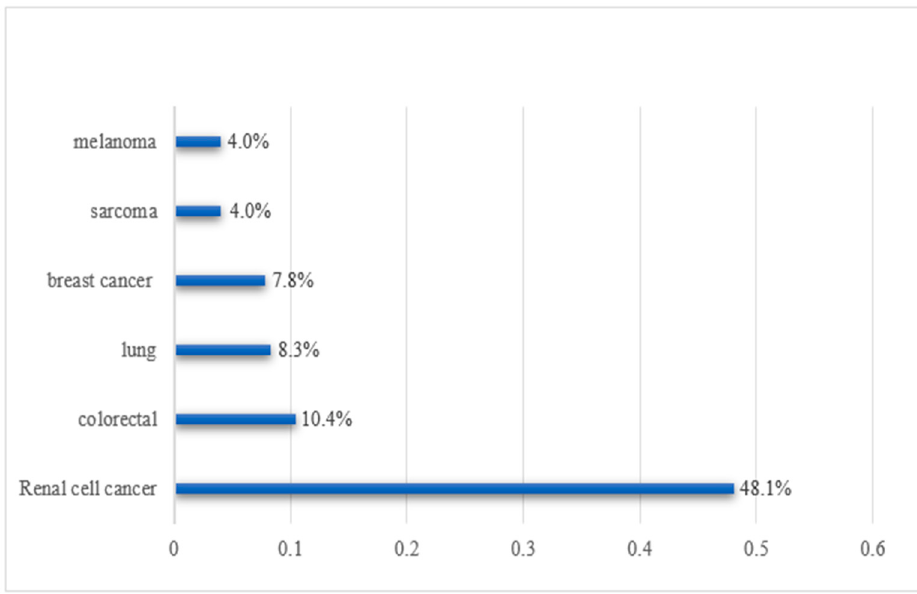
Figure 1. Frequency of metastasis of related malignant tumors to the thyroid